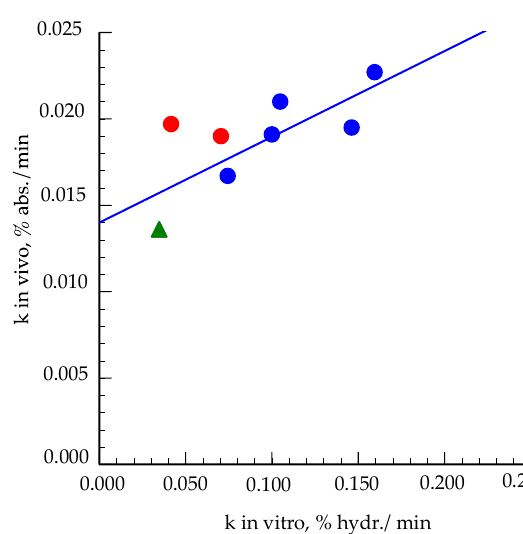
Figure 5. Relationship between in vitro and in vivo k values of the investigated breads of the current study ( J ) and of Western style diet ( J ), arabinoxylan rich diet ( J ) and resistant starch rich diet ( H ) in the study of Vangsøe et al. [17]. The relationship could be expressed with: k in vivo = 0.014 + 0.043 × k in vitro , R 2 = 0.504.